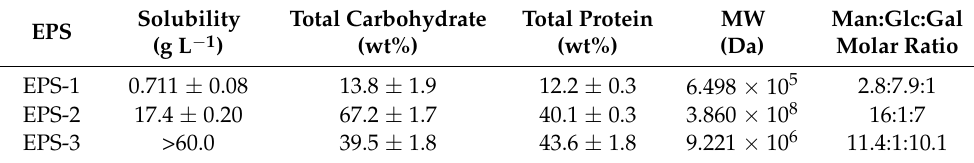
Table 1. Water solubility and molecular properties of three EPS